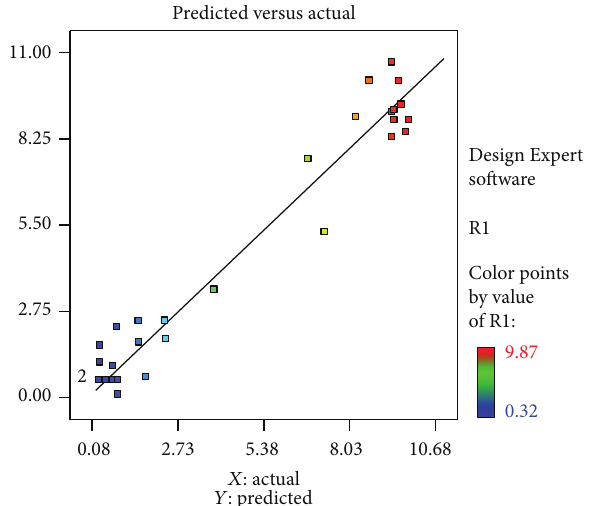
Figure 13: Plot between actual and predicted yield of rifamycin B.